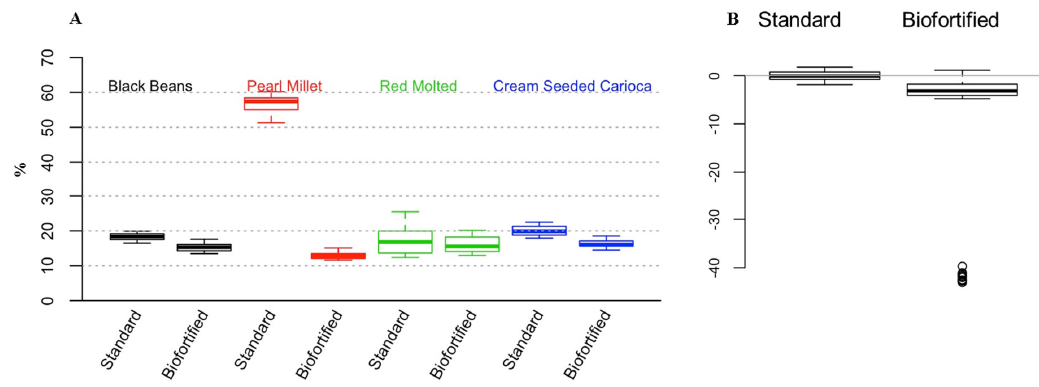
Figure 3. Hemoglobin maintenance efficiency (%). ( A ) Experimental treatment differences (mean ± SEM, p < 0.05); ( B ) overall standardized and cross experimental standard vs. biofortified treatment groups ( p < 0.05).